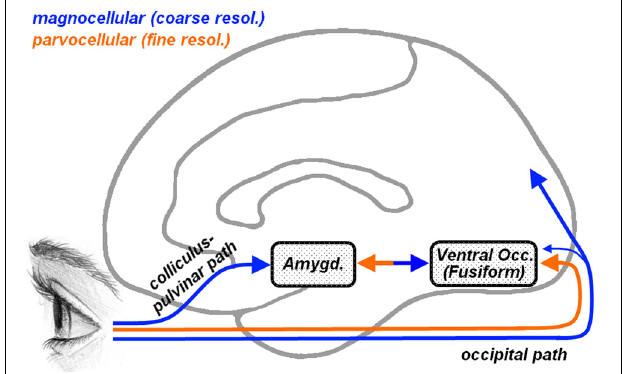
FIGURE 1 | Representation of the cortical and subcortical pathways for visual inputs overlaid on a schematic human brain (medial view). Orange arrows describe parvocellular pathways conveying fine (high-frequency) visual information, whereas blue arrows describe magnocellular pathways conveying coarse (low-frequency) information. Parvocellular inputs reach the striate cortex and project to ventral occipital regions, including the fusiform gyrus. Magnocellular inputs project more dorsally toward the parietal cortex and, to a lesser extent, also toward the ventral occipital cortex. Another magnocellular pathway reaches the amygdala via a subcortical colliculus-pulvinar projection. Fusiform and amygdala are reciprocally